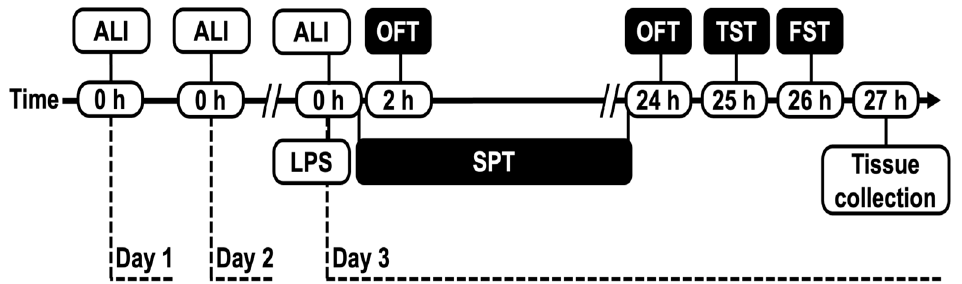
Figure 1. Experimental design.